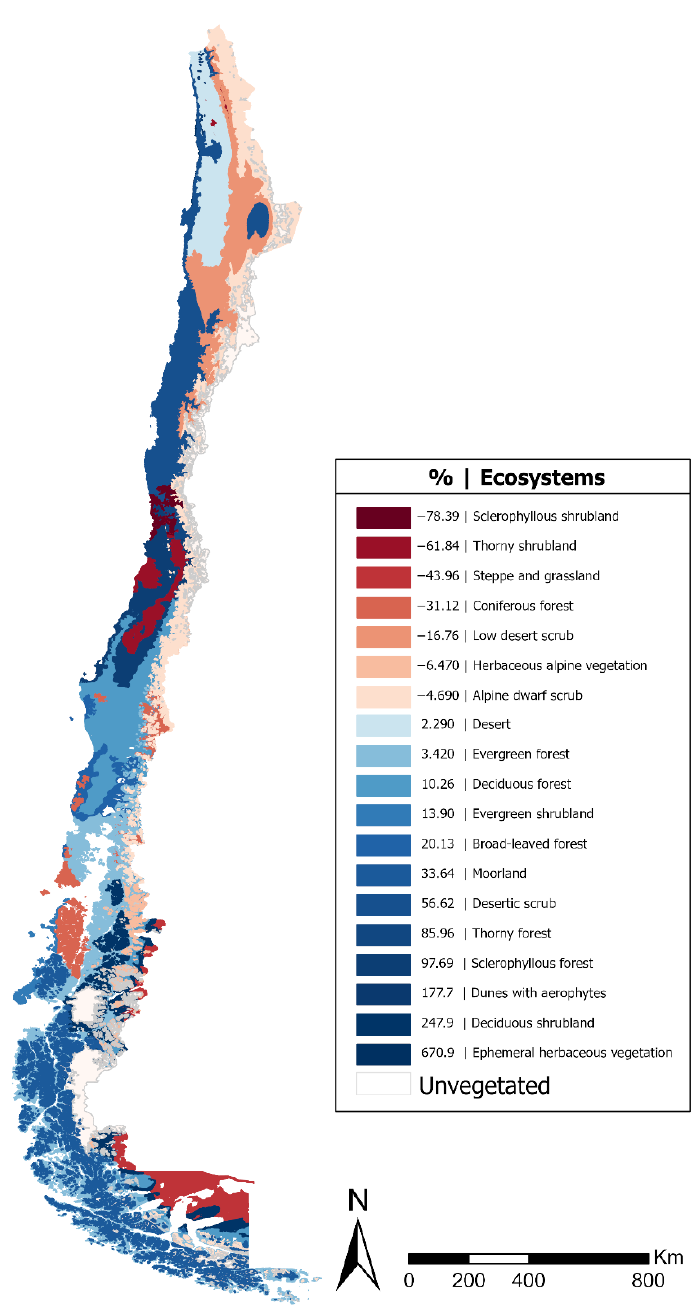
Figure 7. Range of change (average of all scenarios) in vegetation formations from the base period (2020).